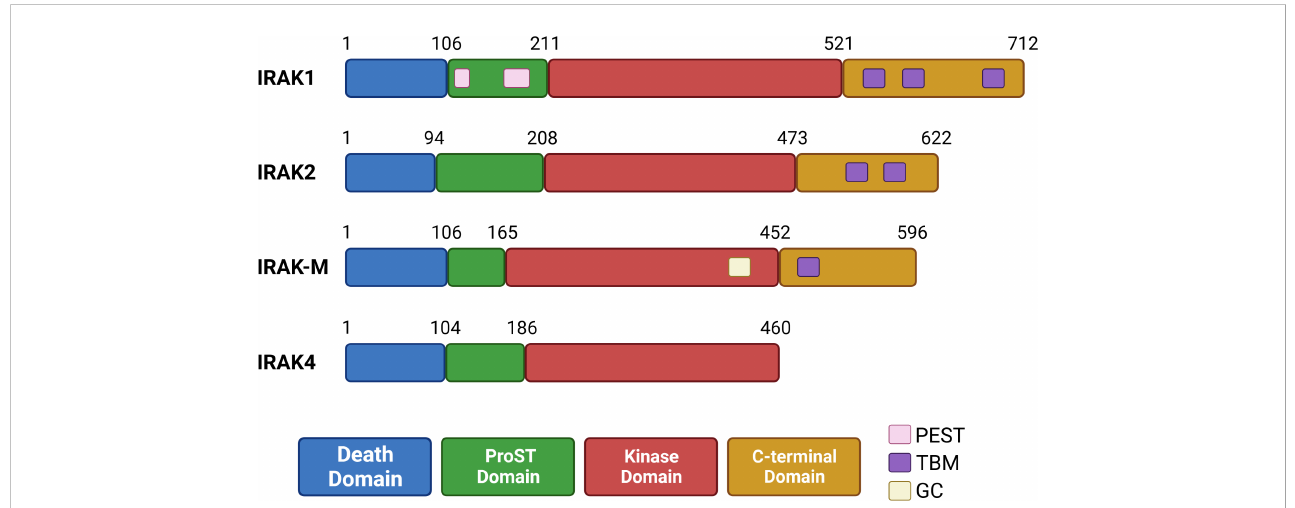
FIGURE 2 Organization of human IRAK proteins. IRAK proteins contain a death domain (DD), ProST domain, kinase domain (inactive in IRAK-M) and a C-terminal domain (absent in IRAK4). IRAK1 has two putative PEST sequences in its ProST region. IRAK-M contains a guanylate cyclase (GC) center in its kinase domain. The C-terminal domain contains up to three TRAF6 binding motifs (TBMs), and is absent in